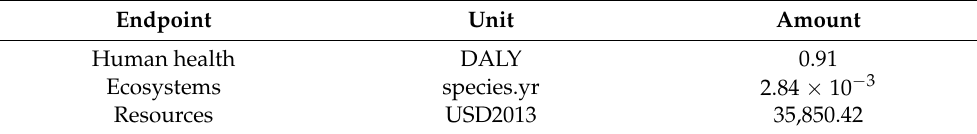
Table 4. ReCiPe2016 environmental damage results for 100TMP in the studied area.